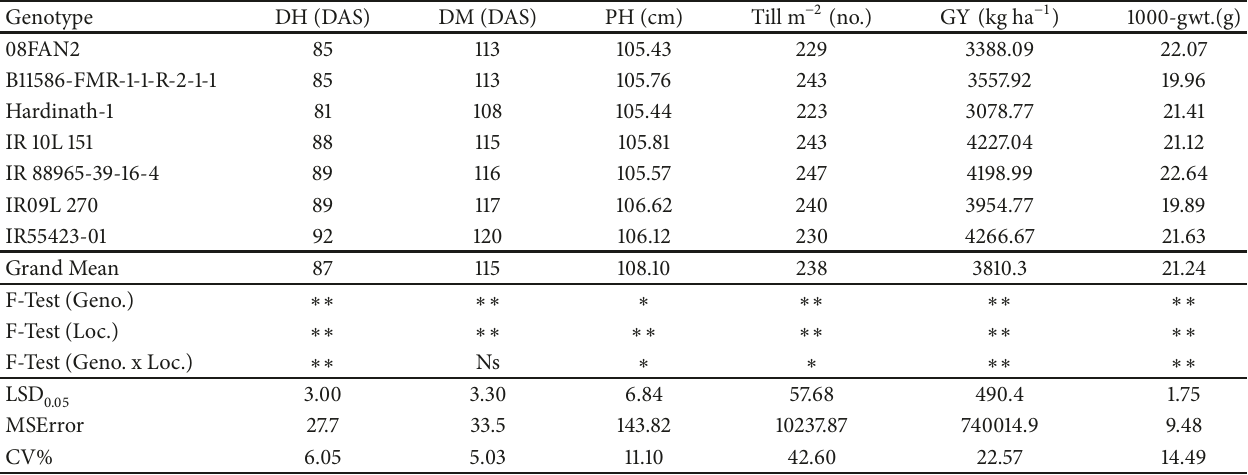
Table 2: Mean genotypic performance of seven genotypes across all location over two years (2015 and